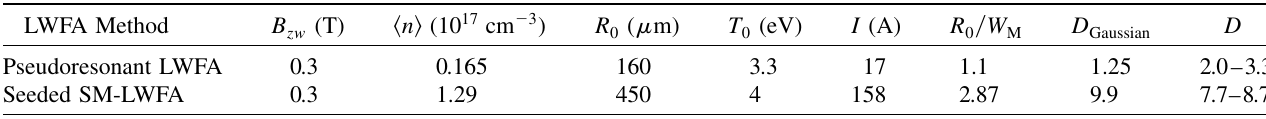
TABLE II. Capillary results and predictions for STELLA-LW experiment assuming an external B-field of 0.3 T. LWFA Method